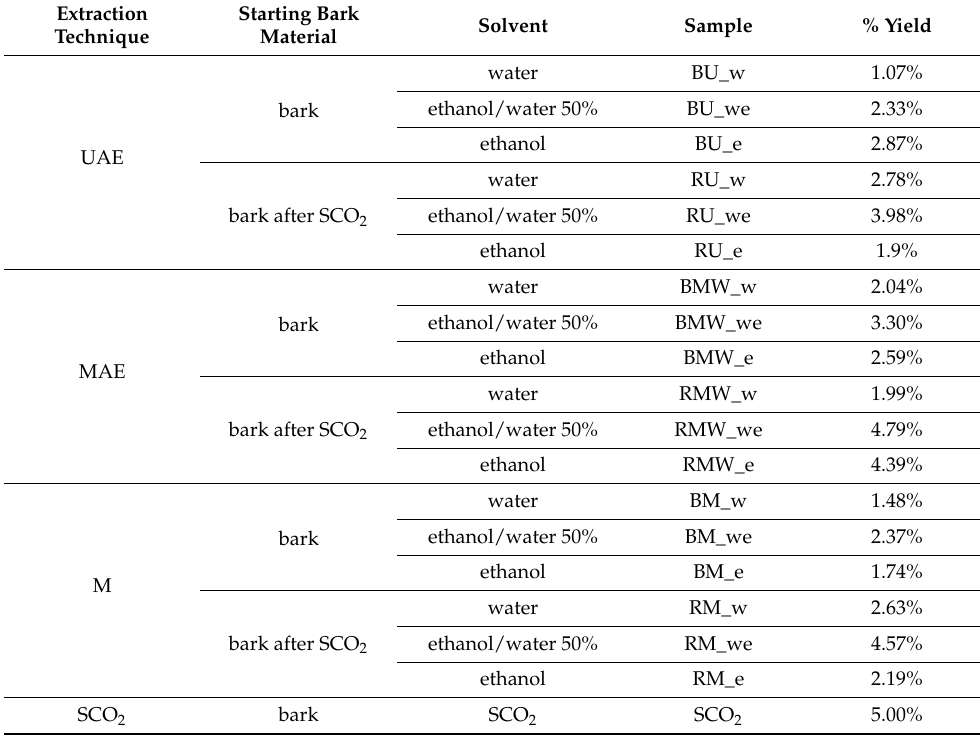
Table 1. Extraction yields and codification names of the nineteen extracts from P. abies.